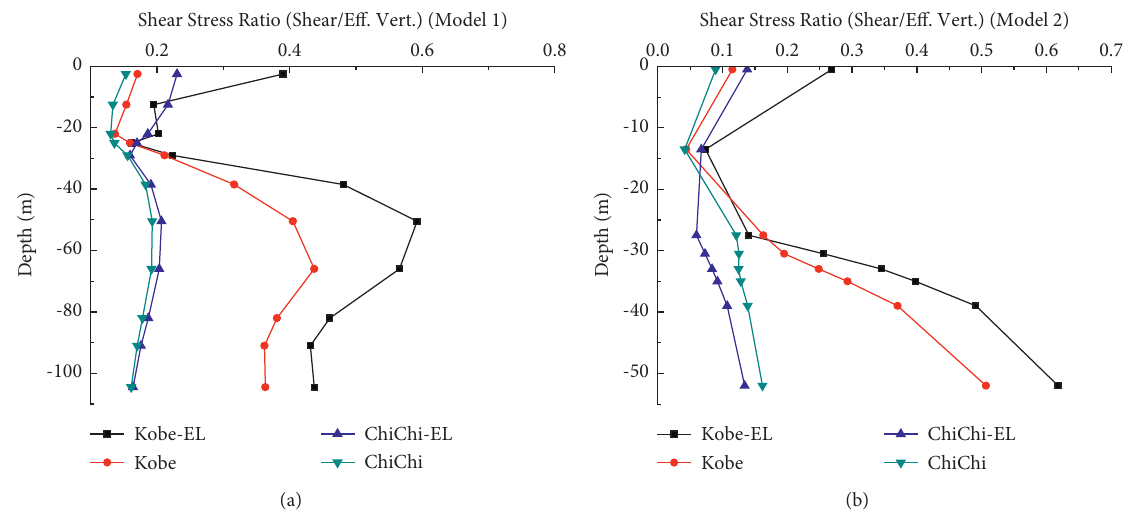
Figure 12: The ratio of maximum shear stress to vertical effective stress varies with depth in model 1 and model